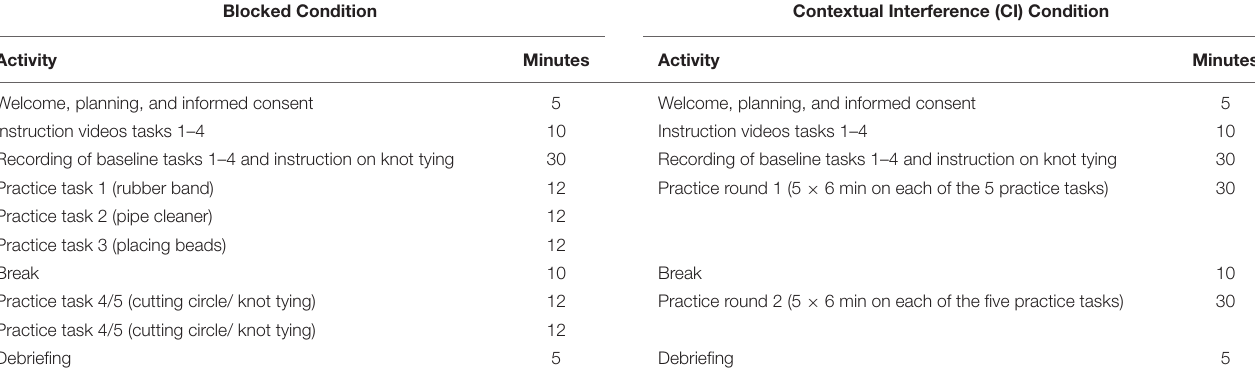
TABLE 1 | Practice schedule of training session I for both